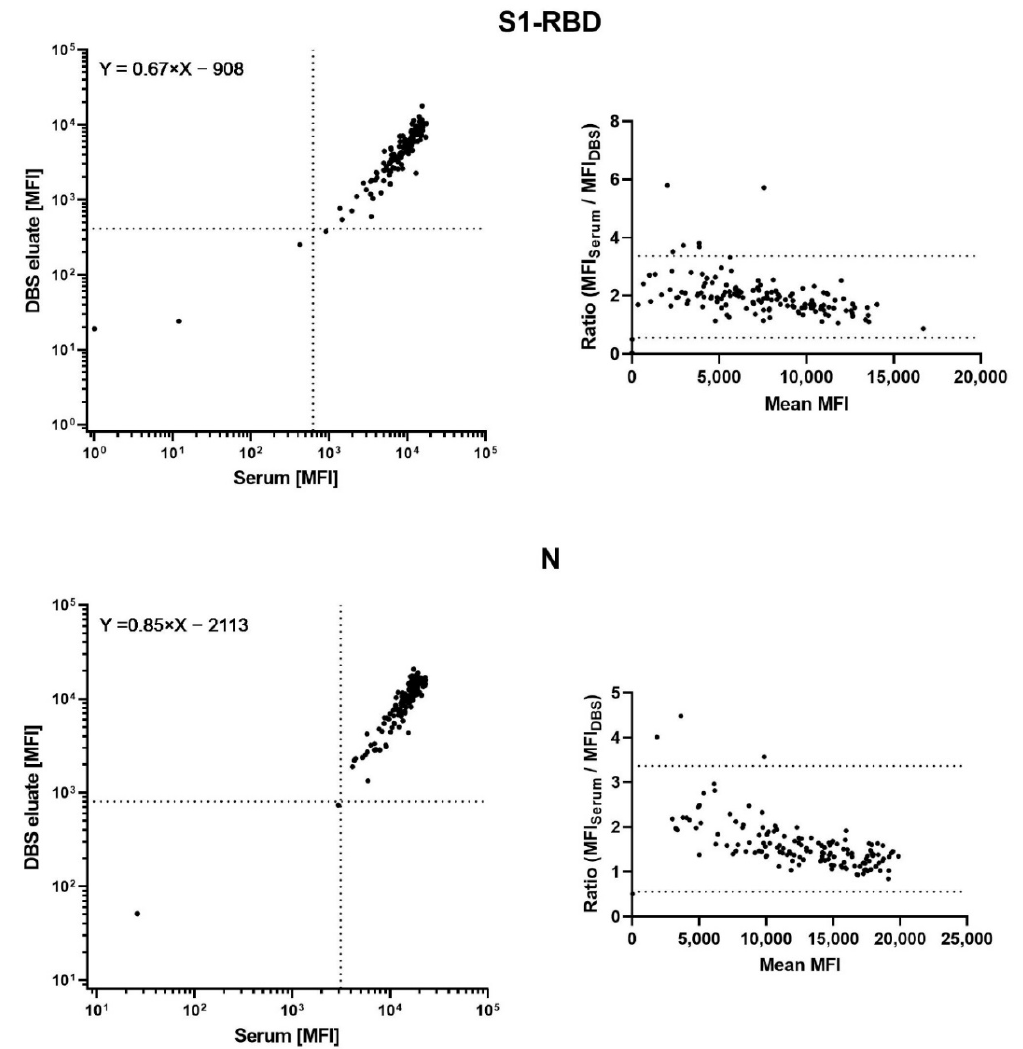
Figure 1. Left : Antibody responses to two structural SARS-CoV-2 antigens (S1-RBD and N), as measured in 142 paired serum and DBS samples and visualized as scatter plots. Linear regression was applied to estimate the general trend between the two data sets. Dotted lines represent respective cutoff values for seropositivity. Right : Bland–Altman plots visualizing the ratio between paired antibody responses across the MFI scale. Dotted lines are located at the mean +/ − 1.96 standard deviations of the